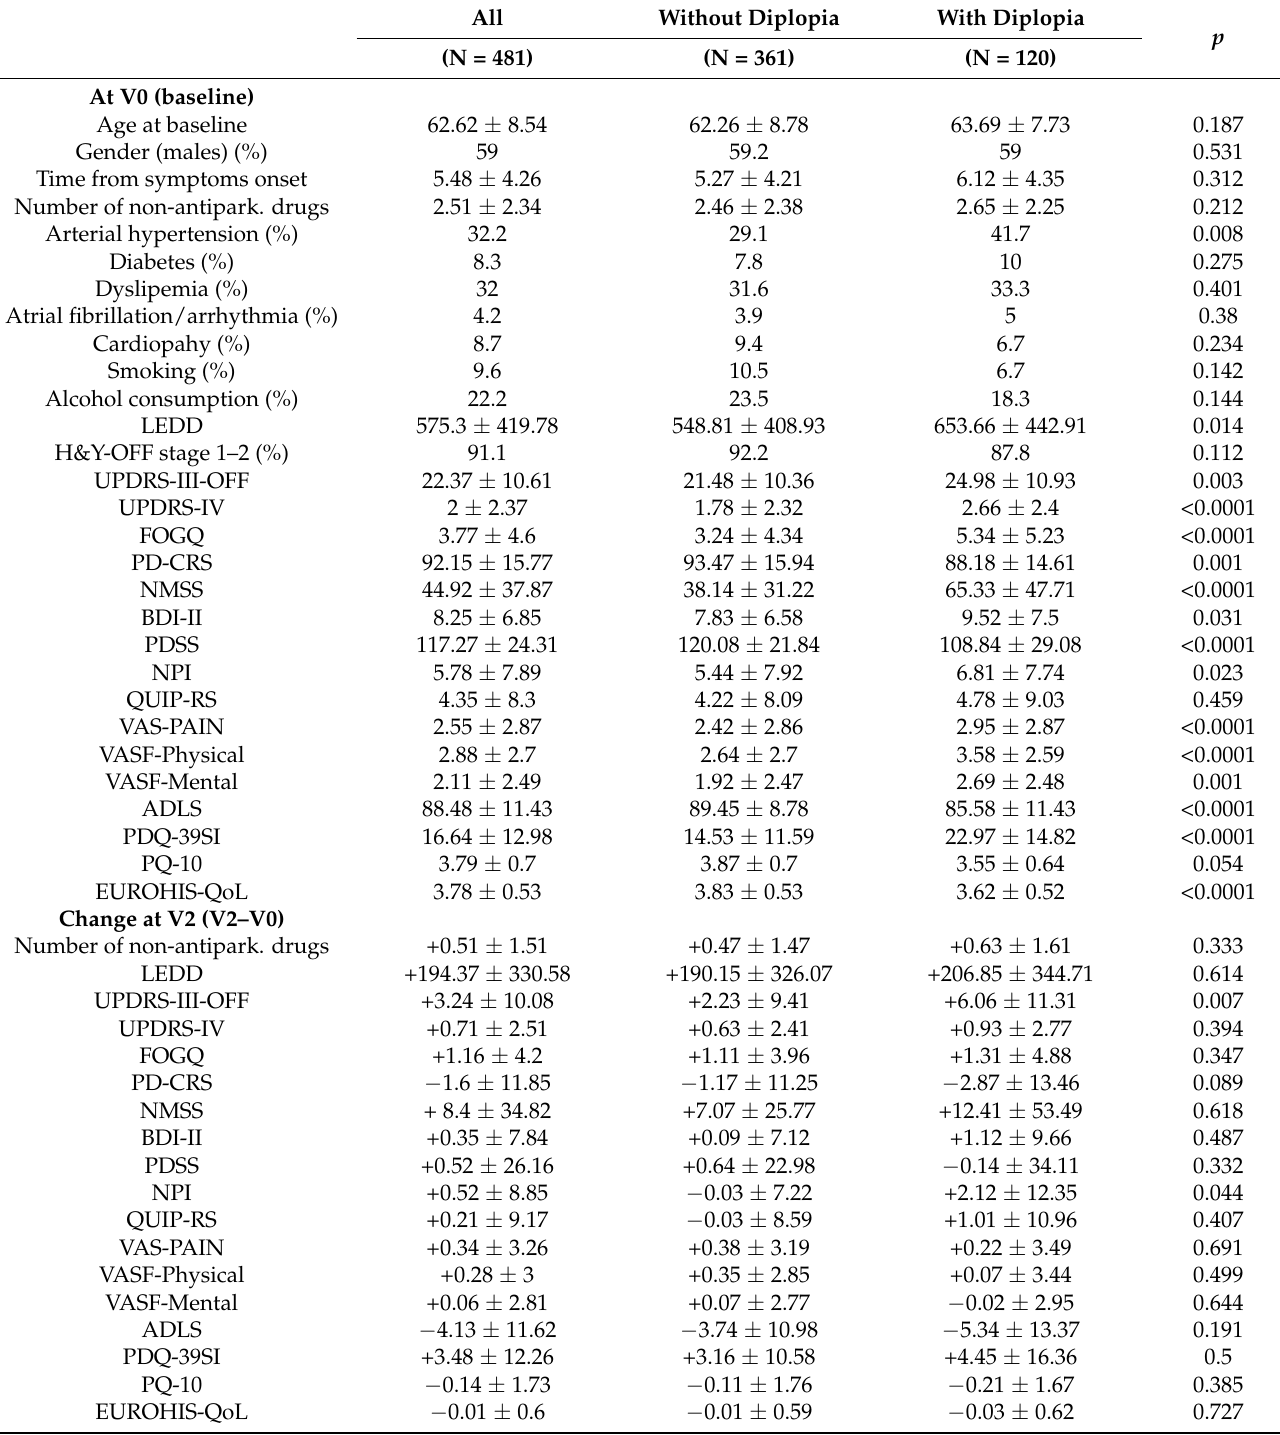
Table 1. PD-related variables in patients with diplopia compared to those ones without diplopia (N =